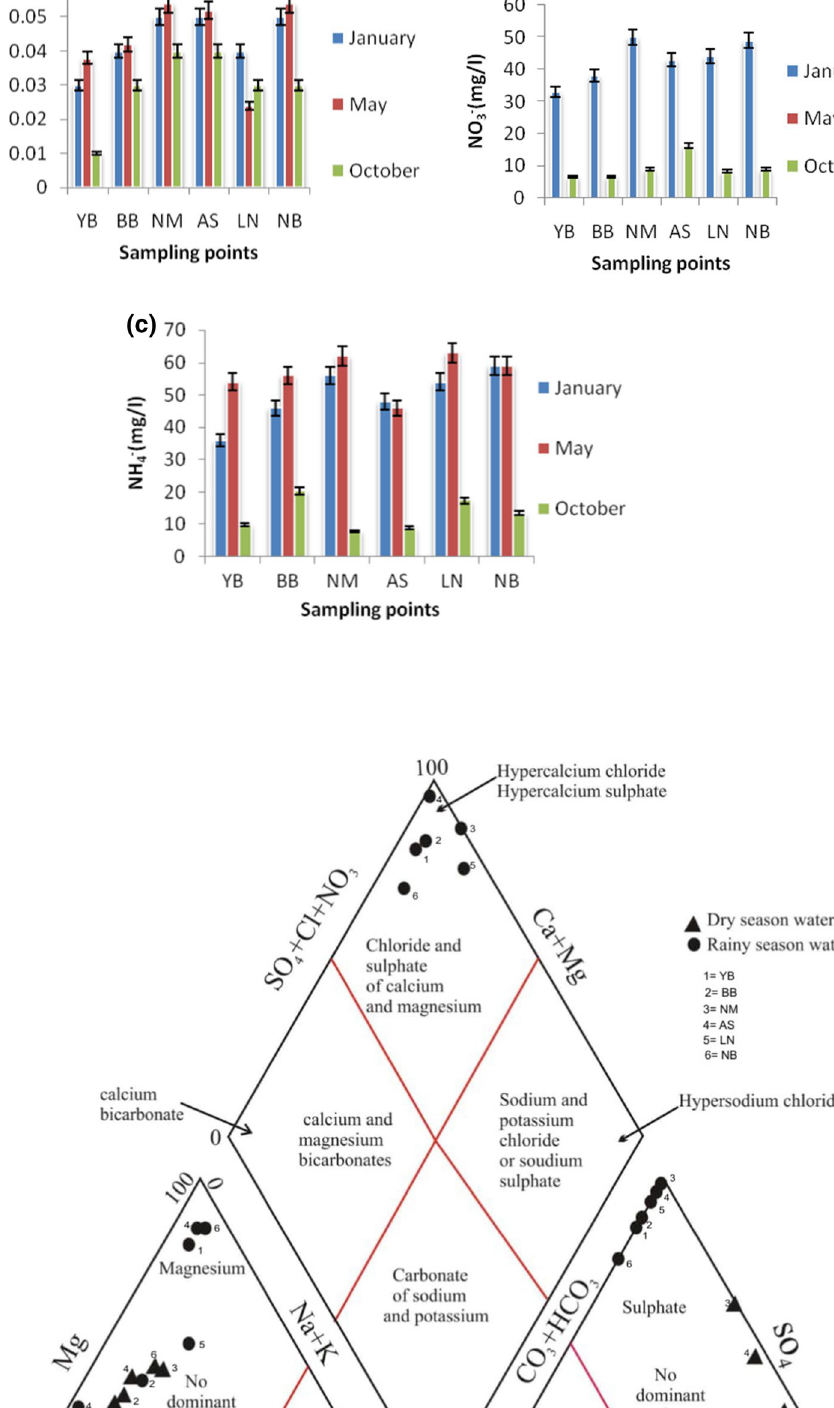
Fig. 5 Seasonal variations of nutrients in the Mezam River water